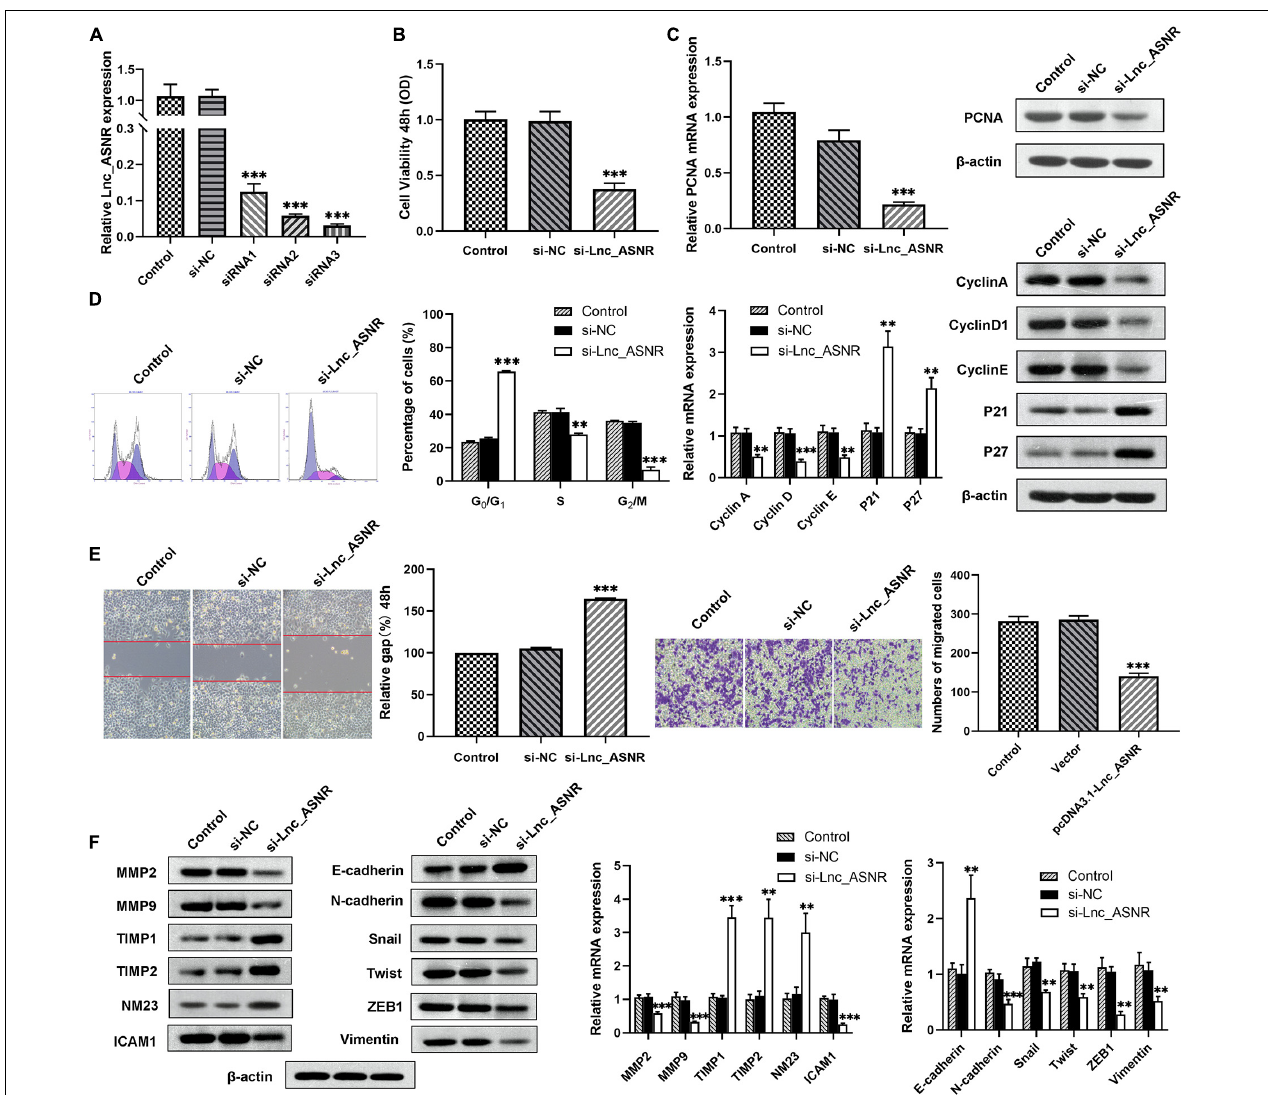
FIGURE 2 | Silenced Lnc_ASNR inhibits GC cell proliferation, migration, and invasion. (A) qPCR showed the silence efficiency of Lnc_ASNR siRNAs. (B) MTT experiments detected the cell viability of MKN45 cells after treatment with Lnc_ASNR siRNA or control siRNAs. (C) qPCR and western blot assays showed PCNA mRNA and protein levels in si-Lnc_ASNR transfected MKN45 cells. (D) Flow cytometry was applied to verify cell cycle in MKN45 cell lines and qPCR and western blot assays were conducted to evaluate the cycle-related mRNA and protein levels. (E) The migration ability with Lnc_ASNR-silenced MKN45 cells was detected by wound-healing assay. The invasion ability was detected by invasion assay with Lnc_ASNR-silenced MKN45 cells. (F) The expression of metastasis-related mRNA and proteins with Lnc_ASNR-silenced MKN45 cells were investigated by performing qPCR and western blot assays. Error bars, mean ± SEM. * P < 0.05; ** P < 0.01; *** P <